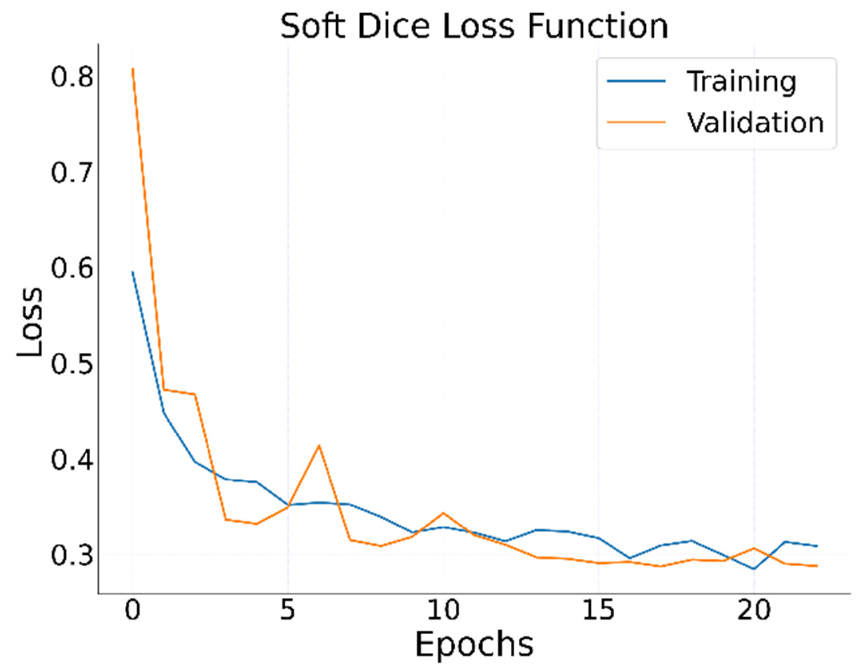
Figure 6. Model’s training and validation Soft Dice Loss curve along 25 epochs.